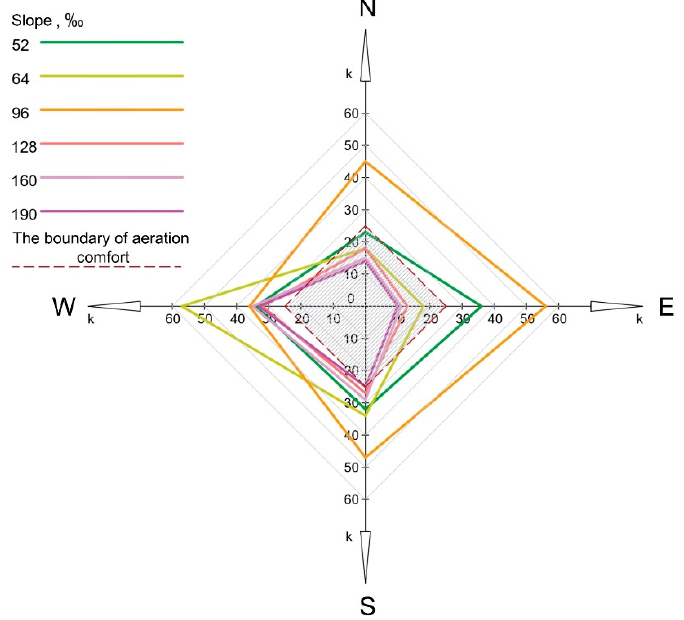
Figure 18. The petal diagram showing the breakdown of discomfortable zones k for the sporadic type of development, at gradients from 52–190‰, and four exposures of the